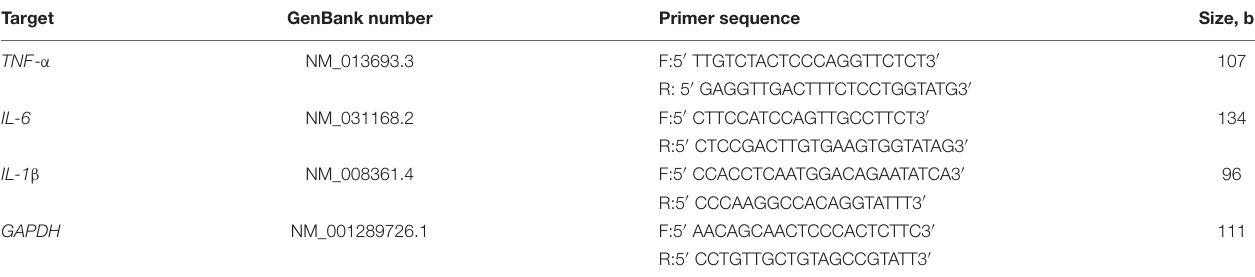
TABLE 1 | GenBank accession numbers, sequences of forward and reverse primers, and fragment sizes used for real-time PCR.